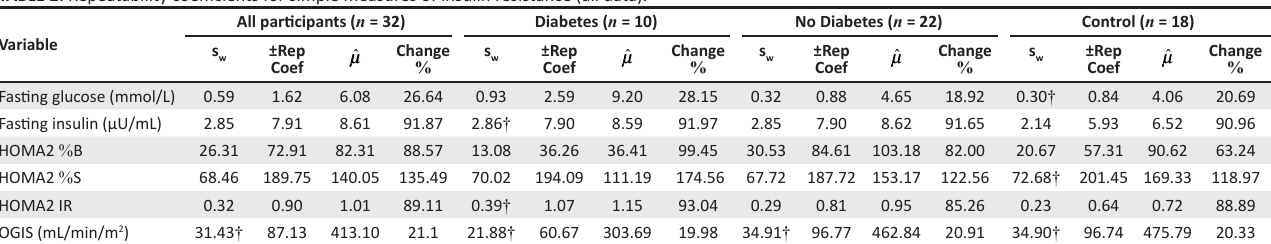
TABLE 2: Repeatability coefficients for simple measures of insulin resistance (all data).